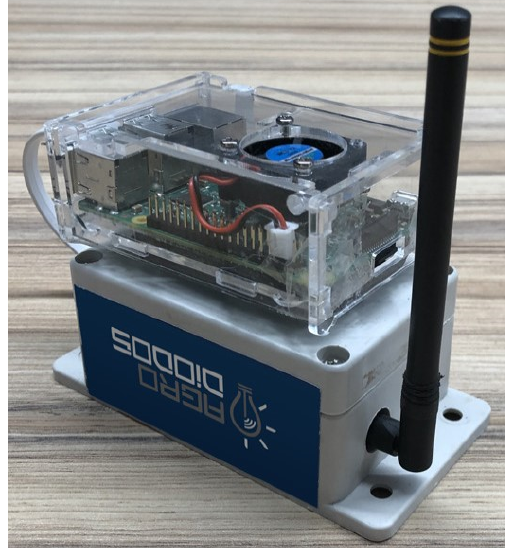
Figure 7. The Super